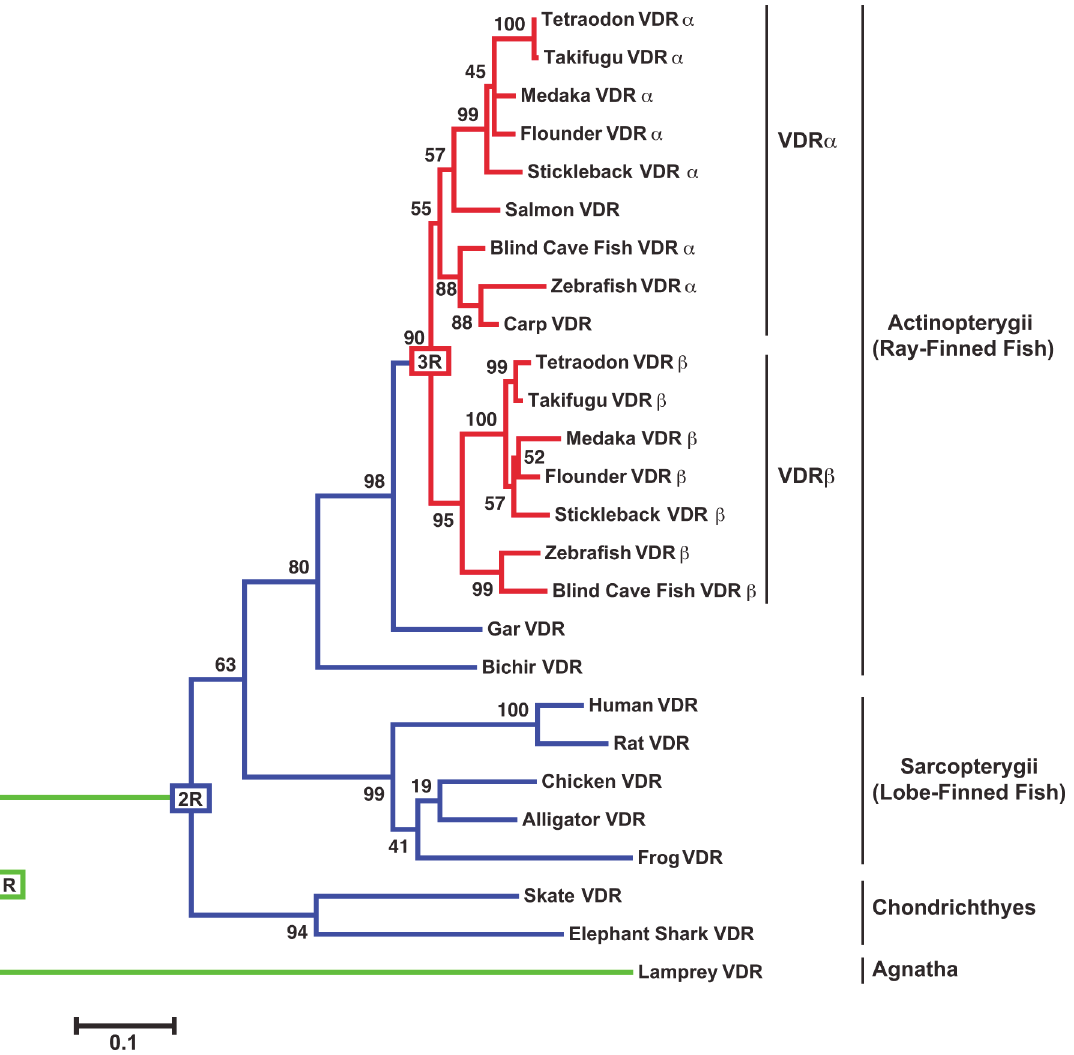
Fig 2. Phylogenetic analysis of full-length VDR amino acid sequences in vertebrates. Phylogenetic analysis was conducted in MEGA 5. This tree was estimated using the Maximum Likelihood method based on the JTT matrix-based model. The analysis was bootstrapped (500 pseudosamples) to assess robustness. The percentage of replicate trees in which the associated taxa cluster together in the bootstrap tests is illustrated at each node. The tree is drawn to scale, with branch lengths measured in the number of substitutions per site. The locations of each WGD (1R, 2R, and 3R) in vertebrate evolution are indicated on the tree and by branch color: green for 1R, blue for 2R, and red for 3R. The GenBank accession numbers for each VDR can be found in S2 Table.